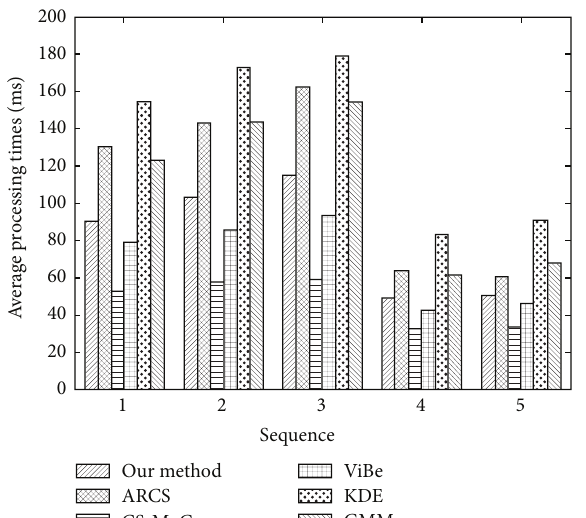
Figure 4: PCCs of six methods.